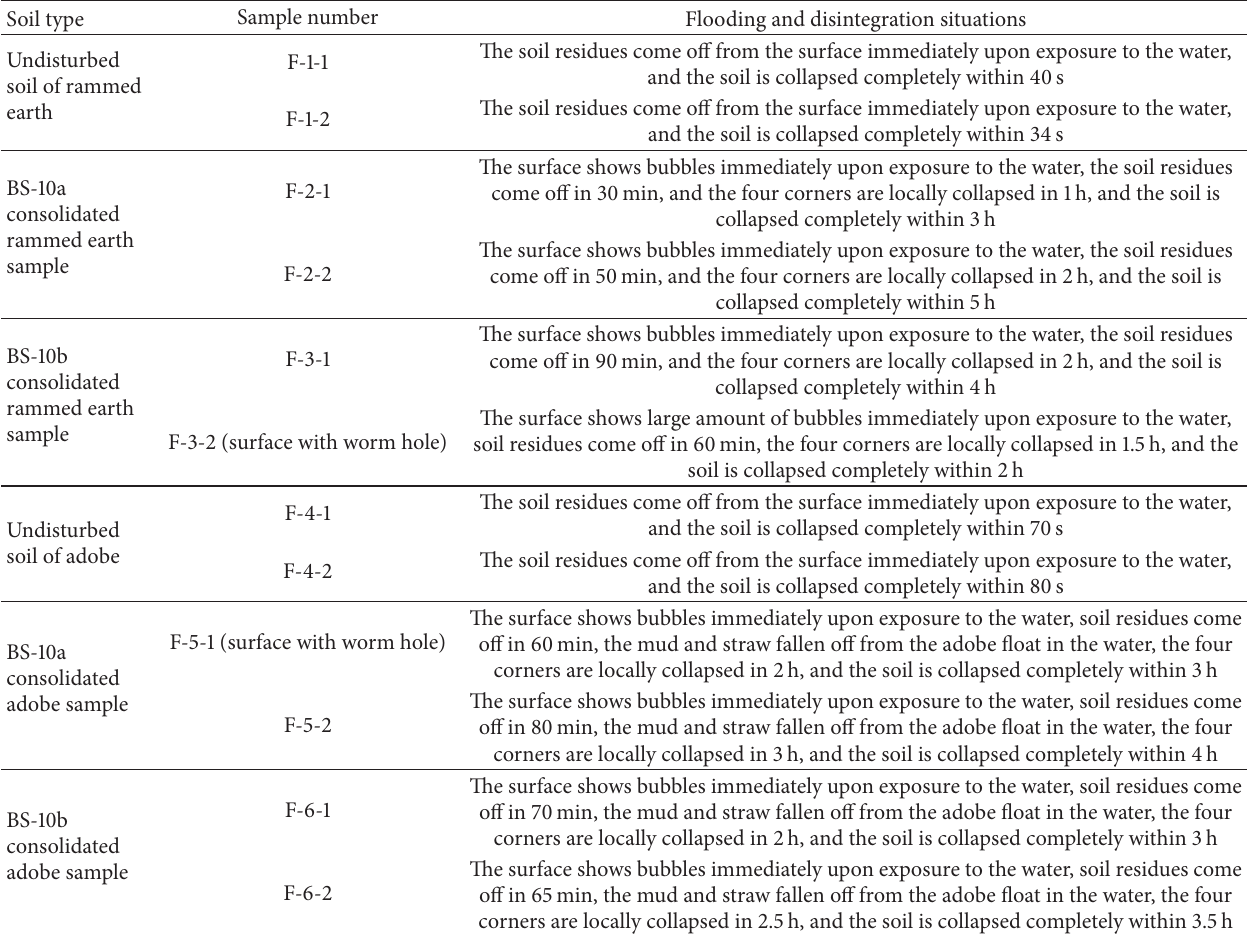
Table 9: Water resistance test results of soil on the archaeological sites of Gaochang